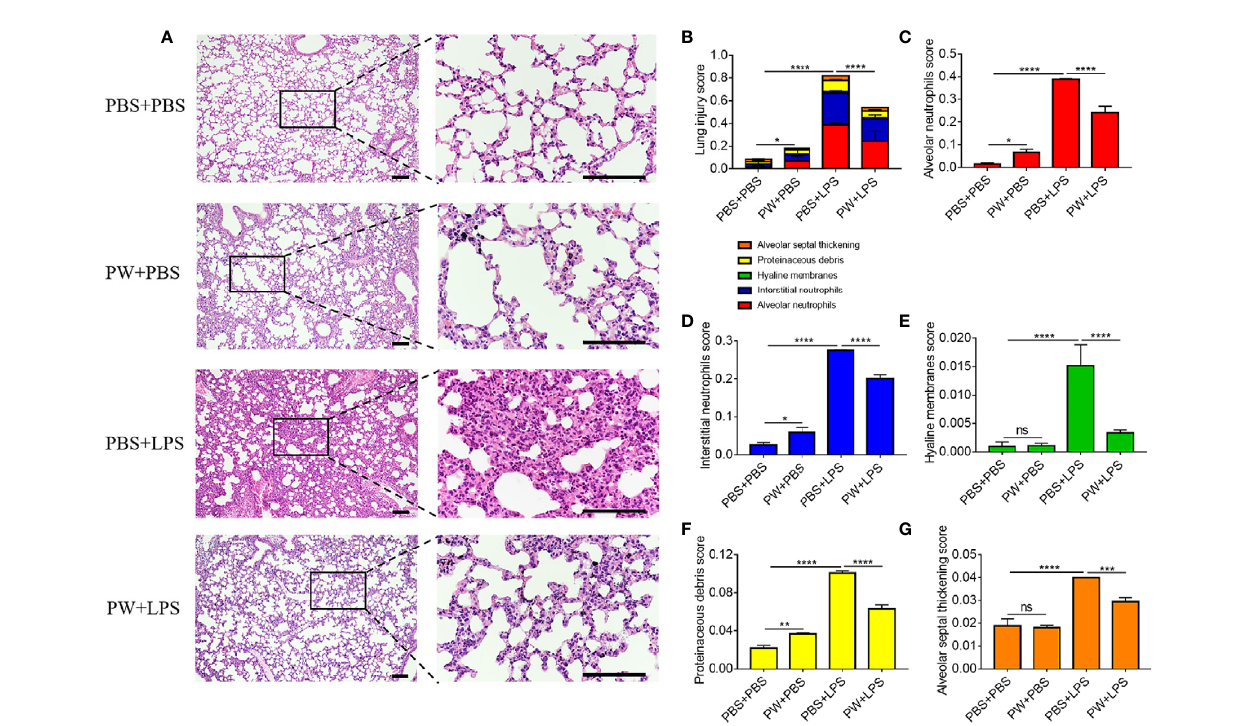
FIGURE 8 | The protective effect of PW on the histopathological damages of the lung in LPS-induced ALI mice. (A) The images of lung sections stained with H&E; the scale bar = 100 µm. (B) The lung injury score based on the 5 pathophysiological characteristics: the alveolar neutrophils (C) , interstitial neutrophils (D) , hyaline membranes (E) , proteinaceous debris (F) and alveolar septal thickening (G) . N ≥ 9 per group; ns, not signi fi cant, *p < 0.05, **p < 0.01, ***p < 0.001, ****p <